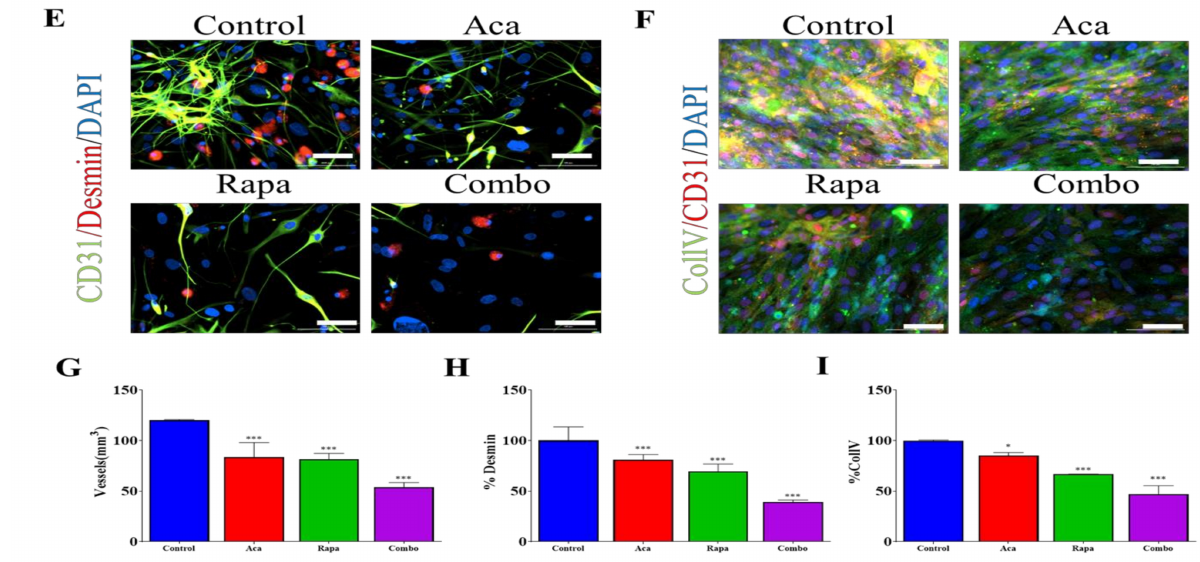
Figure 6. A combination of acalabrutinib and rapamycin inhibited tumorigenesis and vasculogenesis through mTOR pathway inhibition in vivo. ( A ) Graphical representation and photo images showing the effect of 20 mg/kg acalabrutinib, 4 mg/kg rapamycin, or their combination on tumor growth in U87MG-innoculated mice. ( B ) Effect of drug treatment on the weights of tumor-bearing mice. ( C ) TUNEL assay revealing the effect of drug treatment on the apoptotic rate of tumor cells. ( D ) Expression of p-BTK, p-mTOR, p-SK6 and VEGF proteins in tumor samples extracted from tumor-bearing mice. U87MG tumors were collected from mice treated with or without acalabrutinib, rapamycin, or combination therapy at the end of treatment. Sections were stained for CD31 (vessels), desmin (perivascular cells), or collagen IV (for basement membrane) and DAPI (nuclei). ( E ) Microvessel density (MVD), ( F ) perivascular cell coverage (percentage of the desmin/CD31 double- positive area in the CD31+ area), and ( G ) basement membrane coverage were greater in the dual therapy–treated tumors than in the monotherapy-treated tumors. ( H ) Representative images of CD31/desmin staining in the control, acalabrutinib, rapamycin, and combination-treated tumors on Day 21. ( I ) Representative images of CD31/Col IV staining in the control, acalabrutinib, rapamycin, and combination-treated tumors on Day 21. * p < 0.05; ** p < 0.01; *** p <